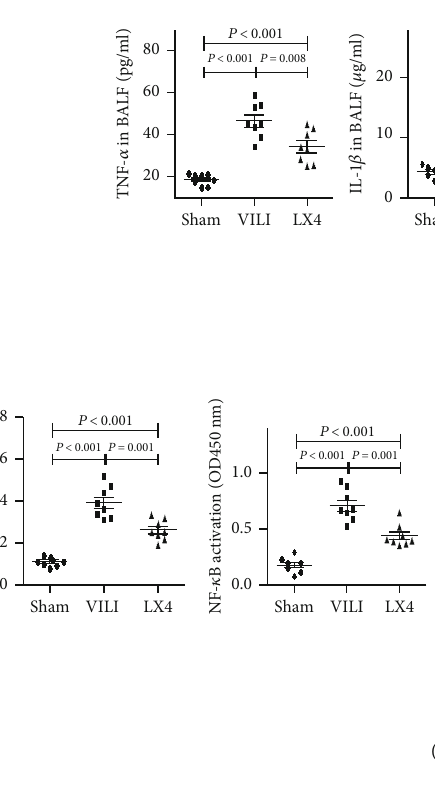
Figure 4: Lipoxin A4 inhibited VILI-induced local in fl ammation. Compared to the levels in the sham group, the levels of TNF- α , IL-1 β , IL-6, and IL-10 were signi fi cantly increased in the VILI group after large-volume MV. Compared to the VILI group, TNF- α , IL-1 β , and IL-6 levels were decreased, and the IL-10 level was increased in the LX4 group (a). The activity and expression of NF- κ B and the expression of p-MLC were notably increased in response to MV. The upregulation of NF- κ B and MLC was signi fi cantly abrogated by lipoxin A4 (b). Similar to the e ff ect on cytokines, the increased in fi ltration of neutrophils and macrophages was also abrogated by lipoxin A4 (c). ∗ P < 0 : 05 , vs. the sham group; # P < 0 : 05 , vs. the VILI group. ● : sham group; ■ : VILI group; ▲ : LX4 group.